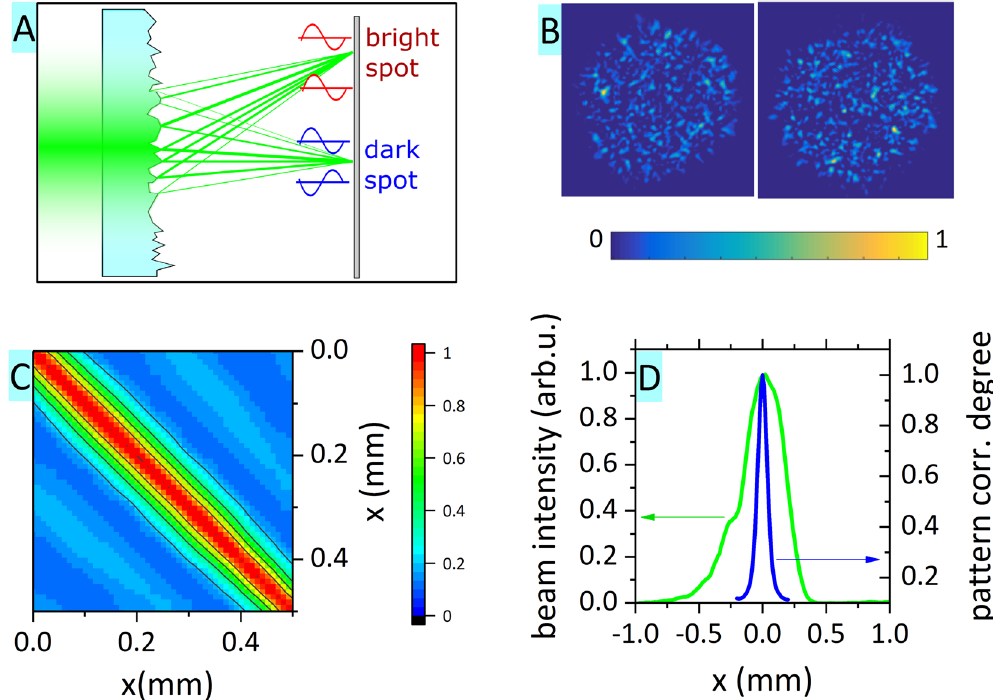
Figure 2. ( A ) Scheme of speckle pattern origin – depending on the random phase, the amplitudes add up (bright spot) or subtract (dark spot); ( B ) Two examples of fine speckle patterns used in the experiments; ( C ) Correlation degree (see text for details) between speckle patterns acquired at different diffusor positions; ( D ) Comparison of beam profile (green line) and averaged correlation degree between neighboring patterns (blue